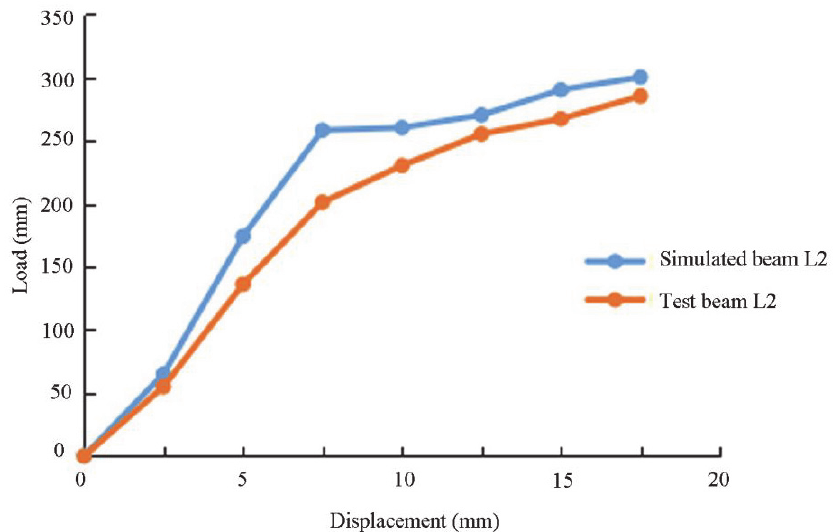
Figure 3: The load-deflection curve of L2.